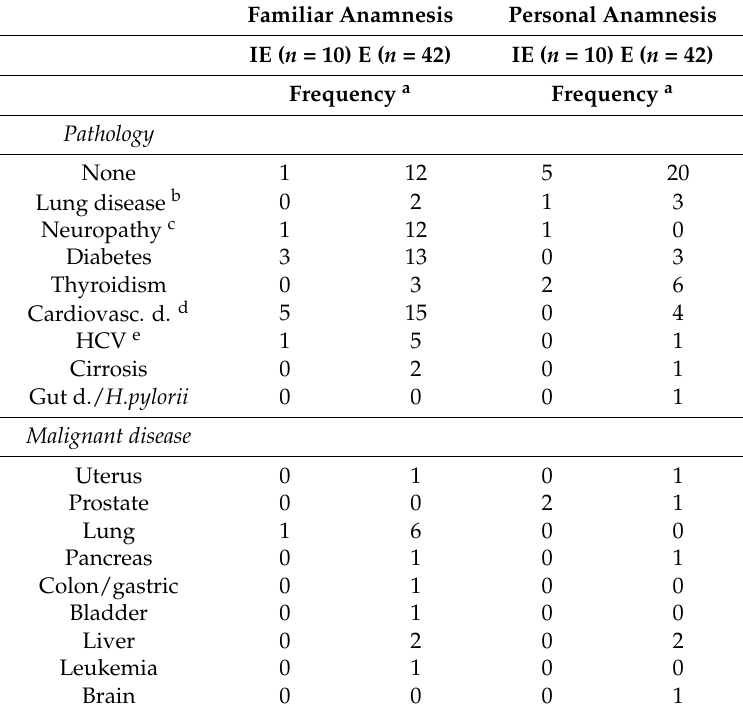
Table 2. Pathologies declared and diagnosed in exposed and indirectly exposed people. Familiar Anamnesis Personal